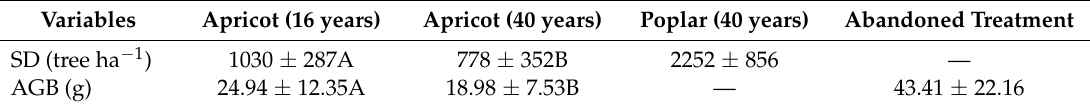
Table 2. Stand density (SD) and above-ground biomass (AGB) of the 16- and 40-year-old apricot treatments, the poplar treatment, and abandoned treatment (mean ± standard